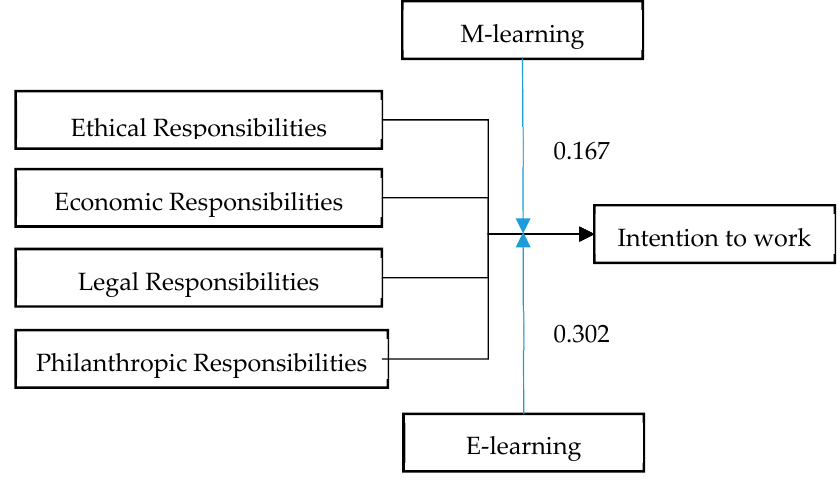
Figure 3. Structural model analysis results.